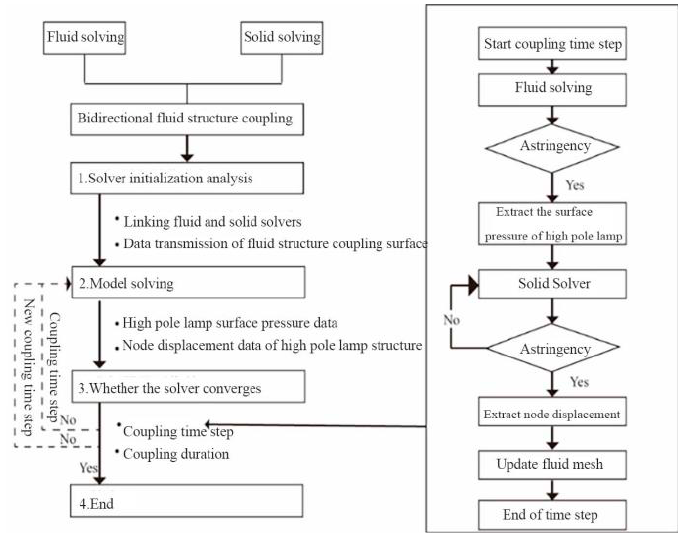
Figure 3. Flow chart for bidirectional fluid ‒ solid coupling calculation.